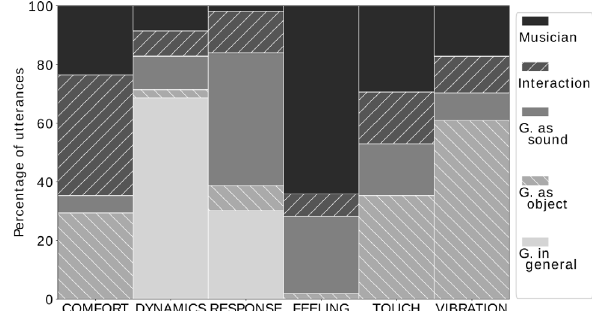
Figure 3. Percentage of each quali fi ed object for each category of words: musician, interaction, guitar (abbr. g.) as sound, g. as object, g. in general.